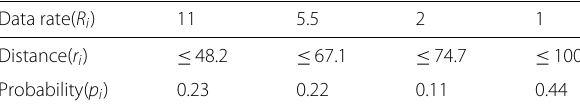
Table 3 Transmission rates and